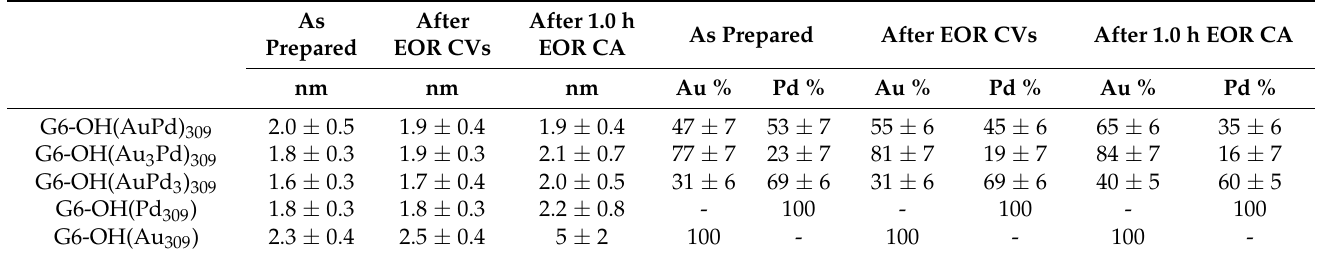
Table 1. Size distributions and Au/Pd compositions of DENs both as prepared and after electrocat- alytic EOR measurements. Size distributions were obtained from 200 NPs. The atomic percentages of Au and Pd were extracted from EDS maps of 5 individual NPs.